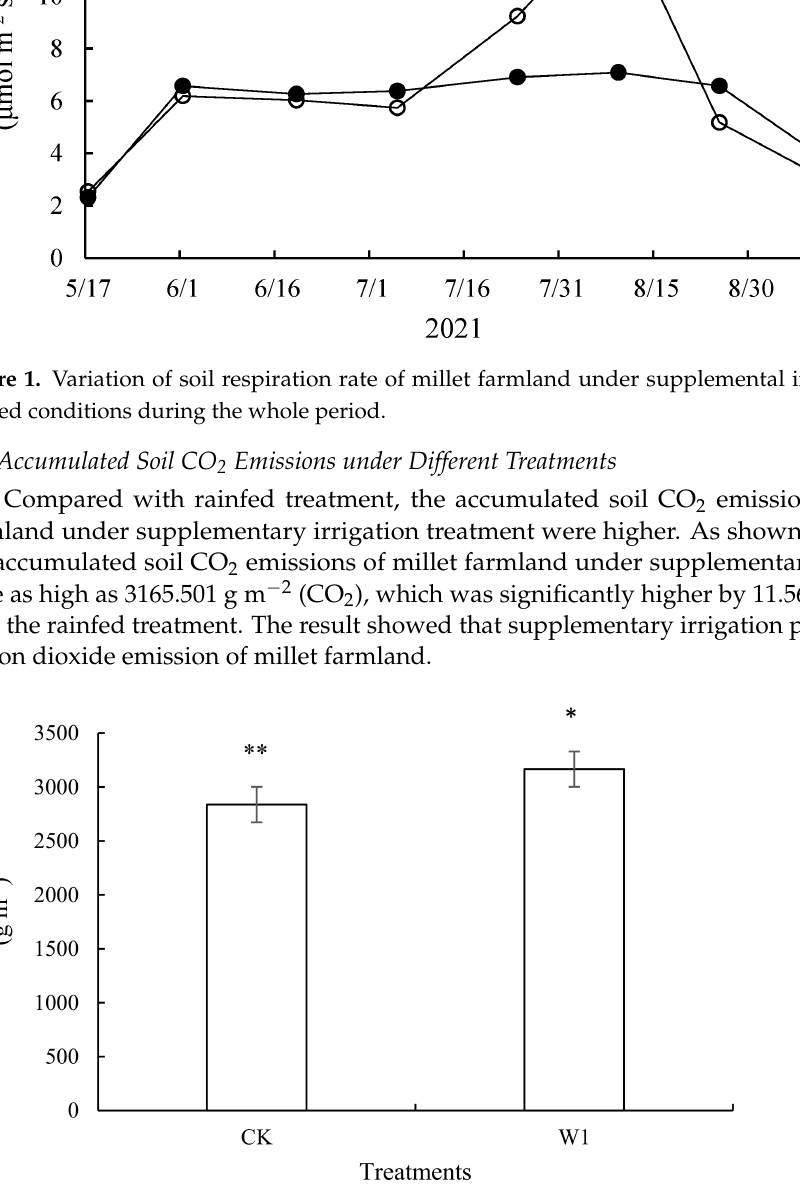
Figure 2. Effect of supplemental irrigation on accumulated soil CO 2 emissions of millet farmland (Note: ** represents an extremely significant effect ( p < 0.01) for different soil water treatments during each growth stages and the whole growth period, while * represents a significant effect ( p < 0.05) for different soil water treatments during each growth stage and the whole growth